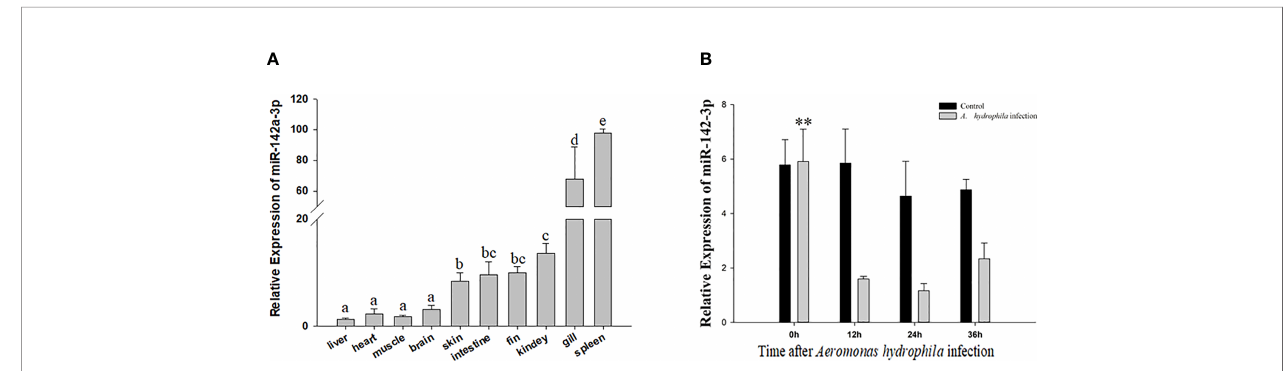
FIGURE 1 | Analysis of miR-142a-3p expression by qRT-PCR (A) in 10 tissues of grass carp (B) in grass carp kidney (CIK) cells 0, 12, 24, and 36 h after A. hydrophila infection. All values represent the mean ± SD of three independent experiments. Different lowercase letters indicate statistically signi fi cant differences (p < 0.05). Asterisks indicate signi fi cant differences (**p <